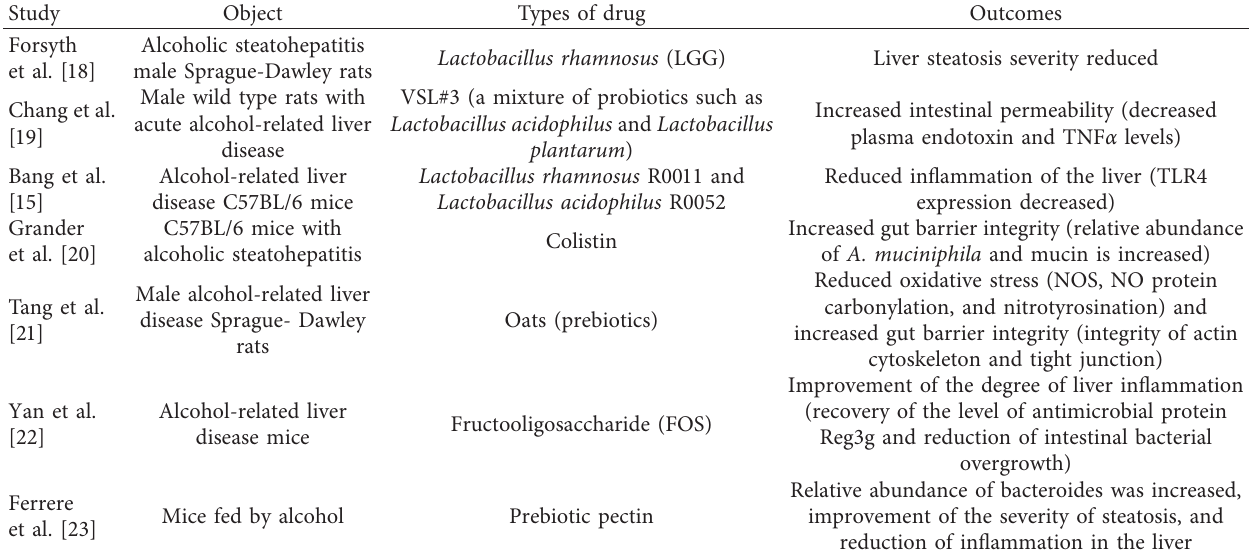
Table 1: Animal experimental studies on the treatment of ALD with probiotics, prebiotics, and synbiotics. Study